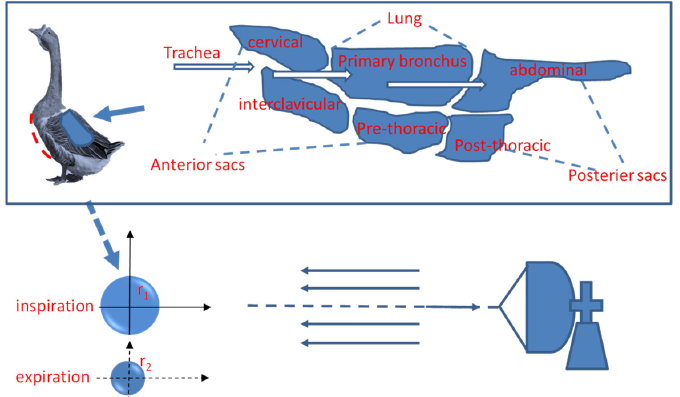
Figure 1. The avian respiratory system with a lateral view of one lung and the water sphere model of a duck.